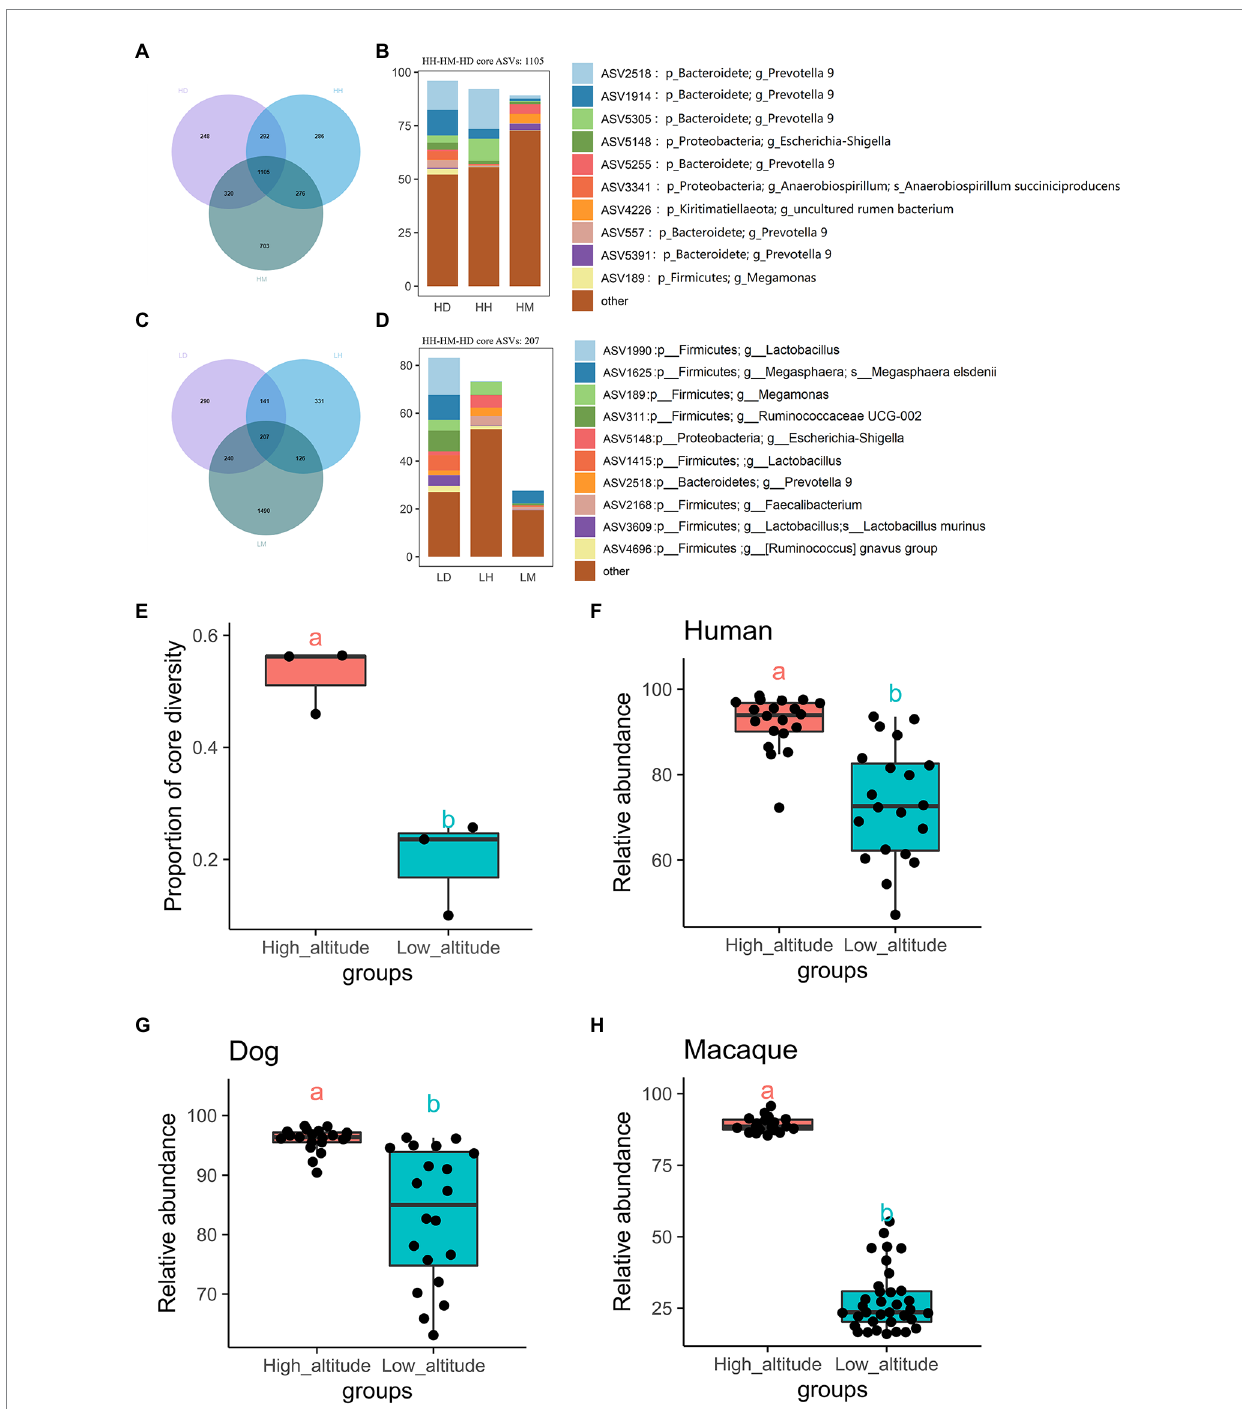
FIGURE 3 Venn diagram and percentage histogram of core ASV between different groups. (A, C) Numbers in plots are marked for how many ASVs are in this part. (B, D) The histogram represents the relative abundance of core ASVs. (E) Differential analysis of the number of core shared microbial species as a percentage of the total number of species in the high and low altitude populations(T-test). (F–H) Differential analysis of relative abundances of core shared microbiota between the three species at high and low altitude (T-test). The same letter indicates the difference is not significant ( p > 0.05), HH stands for high altitude humans, HD stands for high altitude dogs, HM stands for high altitude wild macaques, LH stands for low altitude humans, LD stands for low altitude dogs, LM stands for low altitude wild